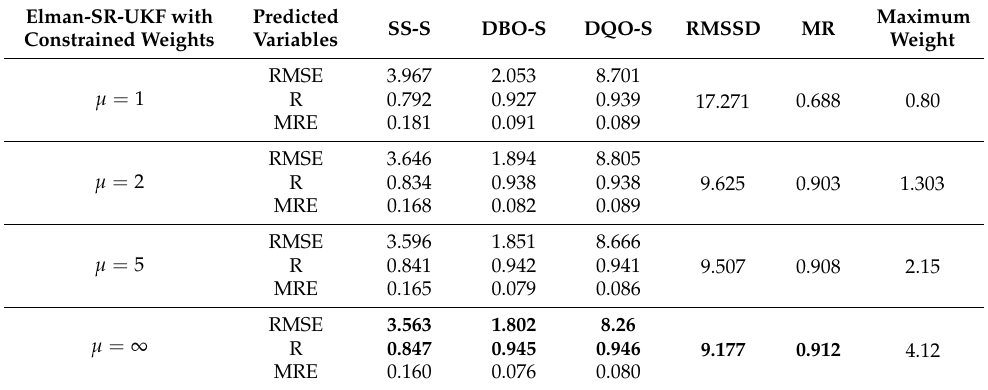
Table 4. RMSE, R, RMSSD, and MR values of the output variables with different weight constraints = 0.05 I ( P x 0